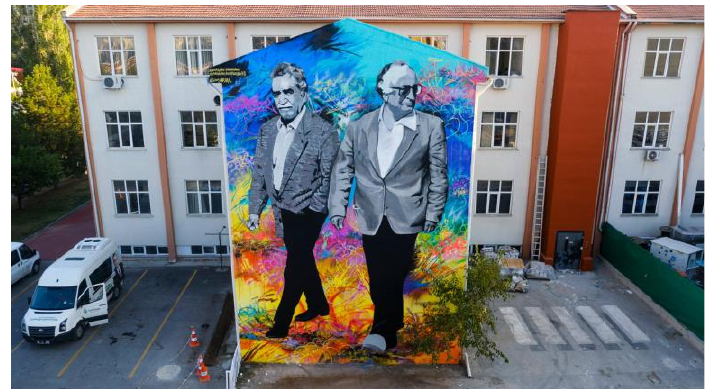
Figure 4 With the theme of 'la Hermandad' (brot herhood), Colombian graffiti artists painted Yaşar Kemal and Gabriel Marcia Marquez on the wall of a Çankaya Municipality building in 2019 in Ankara (Source: URL-7).